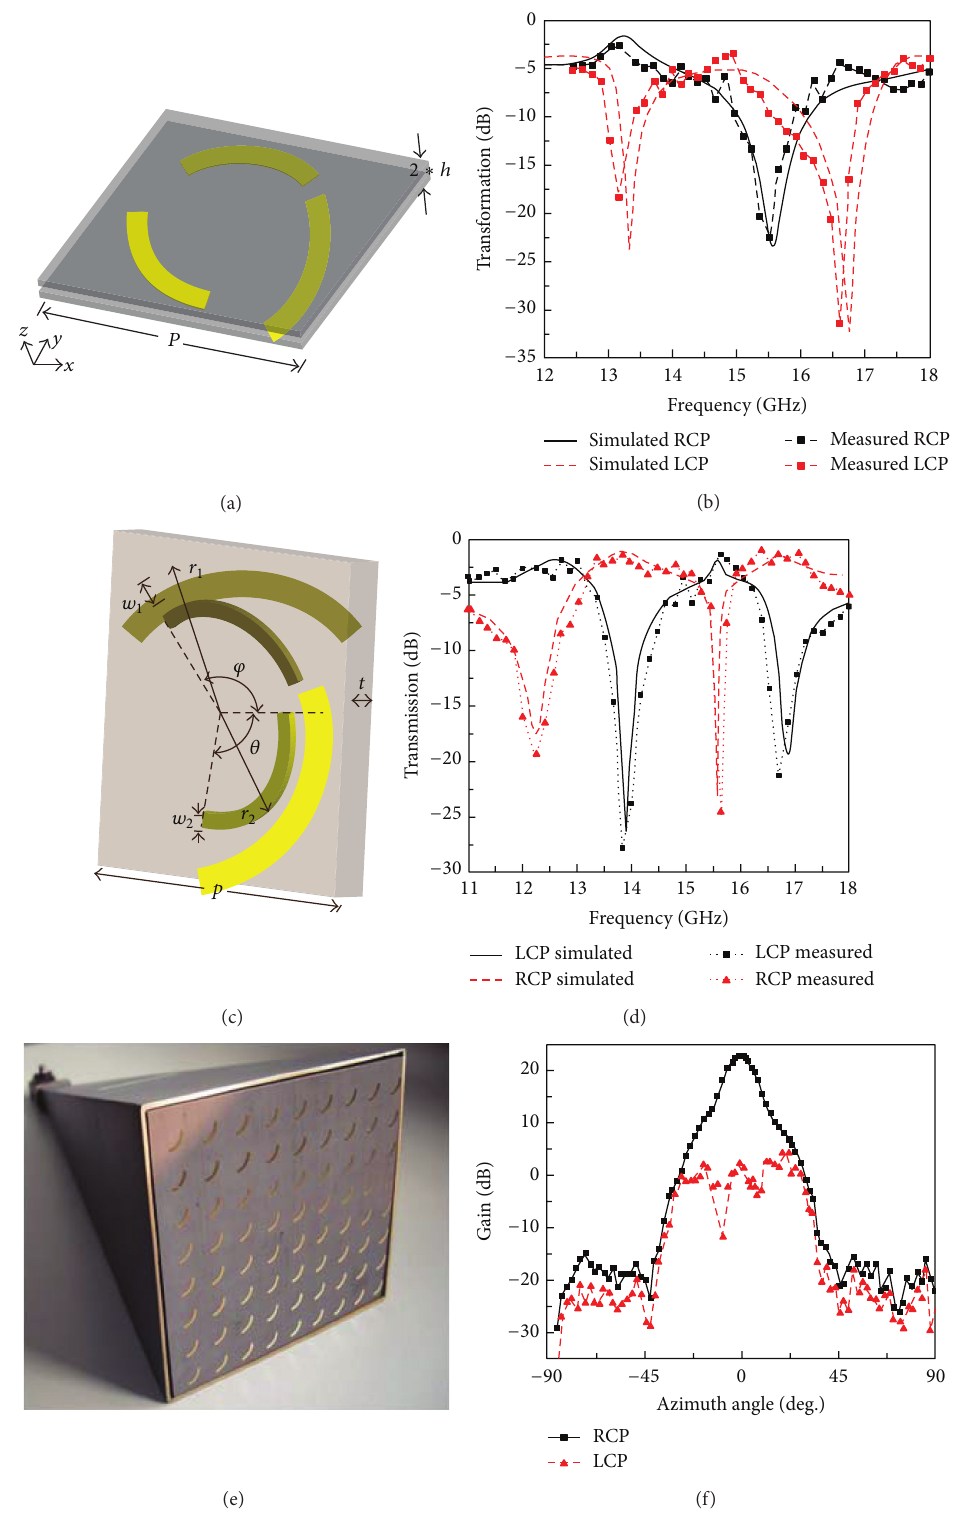
Figure 12: Schematic configuration of the (a) triple-band circular polarizer, (c) four-band chiral metasurface, and (e) dual-band circularly polarized horn antenna based on chiral metasurface. (b, d) Simulated and measured circular transmission for the chiral metasurface of (a) and (c). (f) Radiation patterns in LCP and RCP of the antenna at 14.35 GHz. Figures are reproduced from [86, 89,